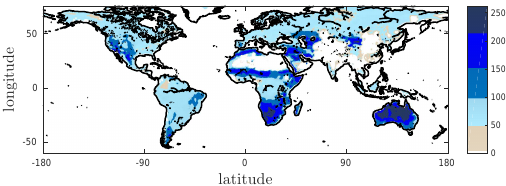
Figure 7. Numbers of training samples for each grid for SMOS ascending overpass in the training phase.